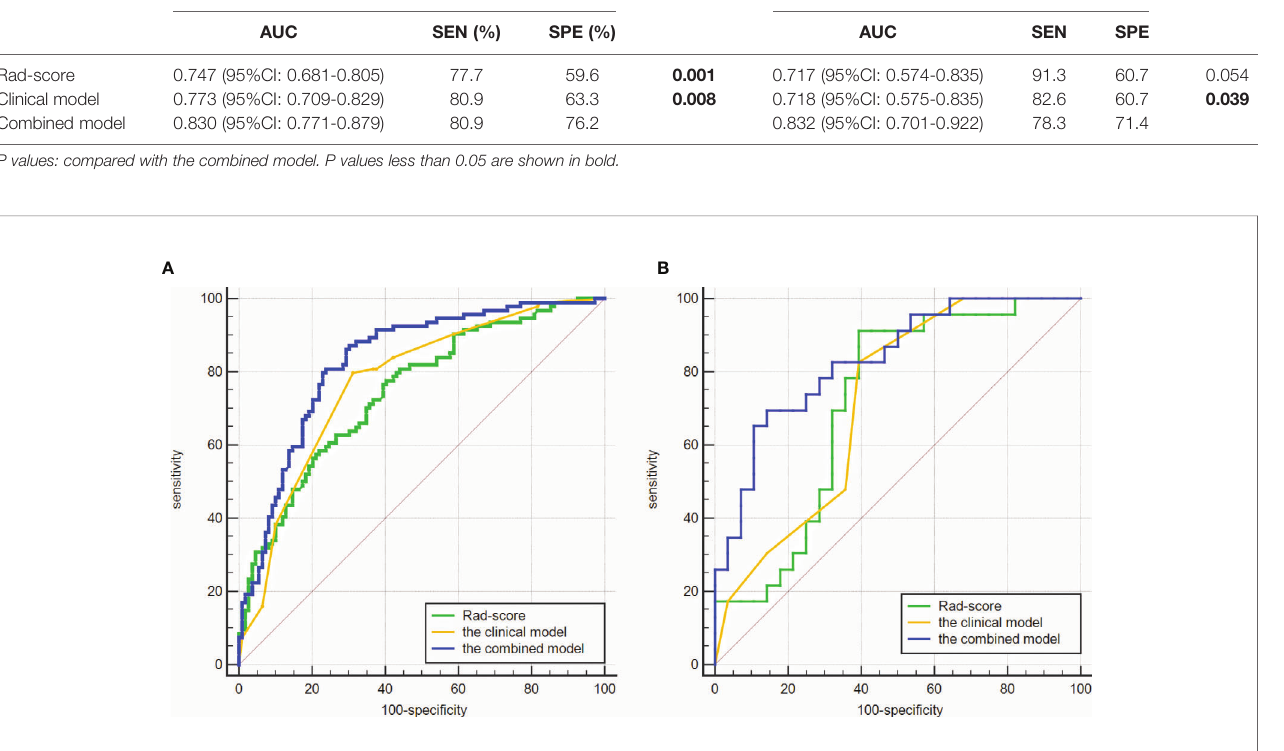
TABLE 3 | ROC analyses of the models in the training and validation cohorts. Model